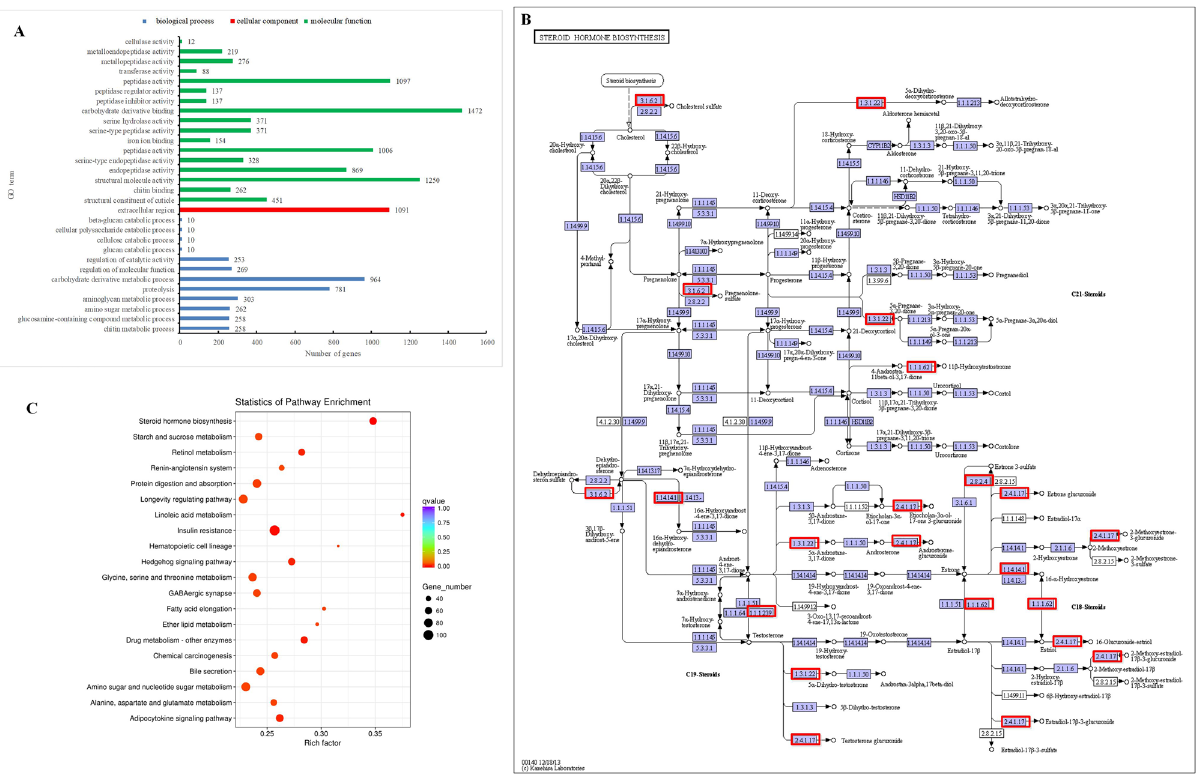
Figure 4. Gene ontology (GO) and Kyoto Encyclopedia of Genes and Genomes (KEGG) enrichment analysis of 10,695 DEGs among six comparisons of adjacent molting stages in the Scylla paramamosain molting